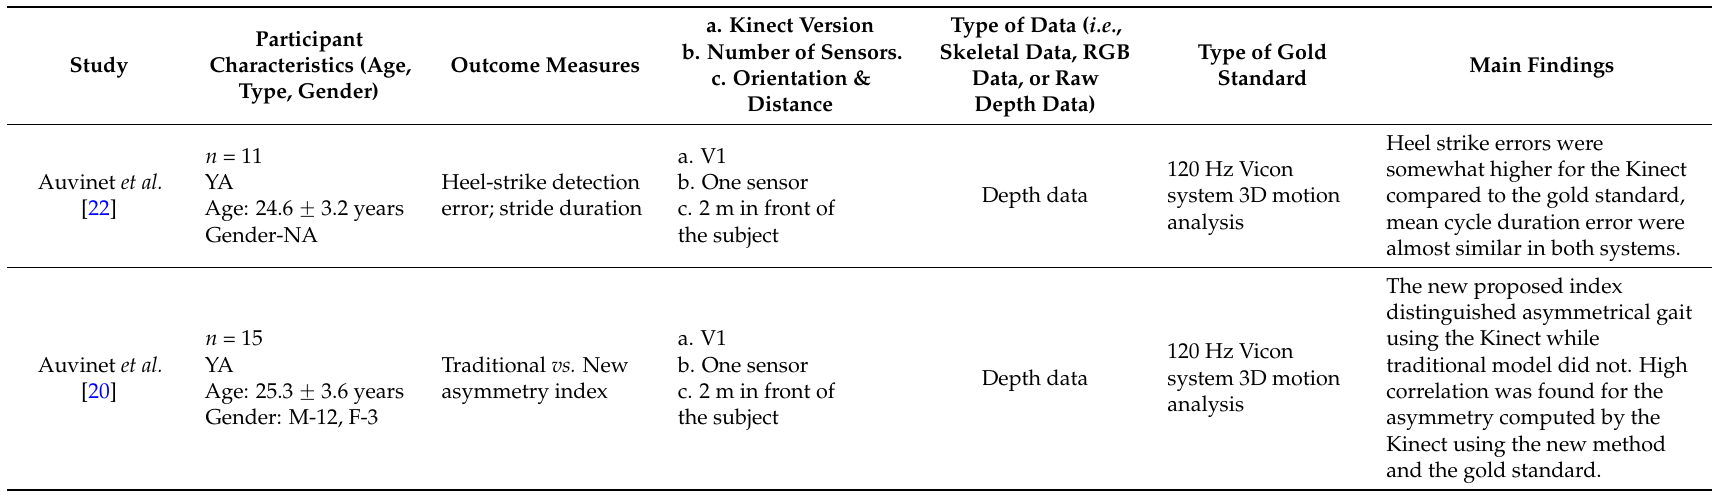
Table 2. Characteristics of the identified